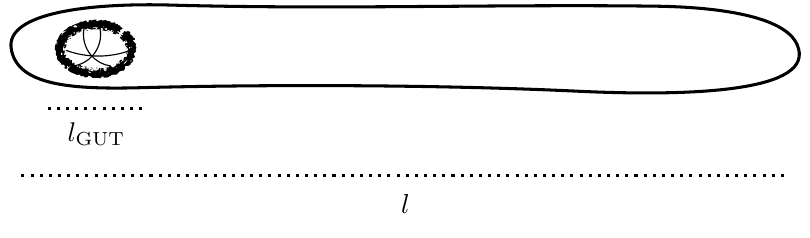
Figure 2 . Schematic representation of the Dark Dimension in an F-theory GUT scenario. Higher towers of SM fields localized in the GUT brane kick in at ˆ M , significantly changing the Higgs potential and preventing the onset of the instability noticed in